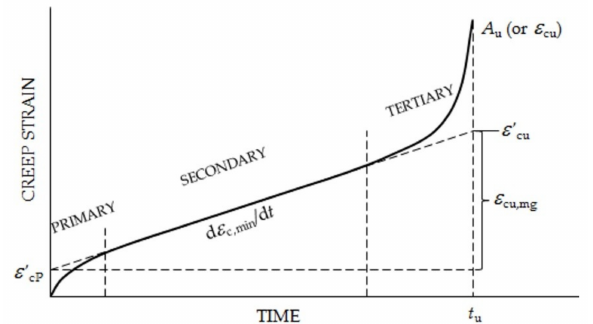
Figure 1. Variation of creep strain with time to rupture in constant load tests (creep rupture strain and elongation at rupture are only the same when there is insignificant instantaneous plastic strain on